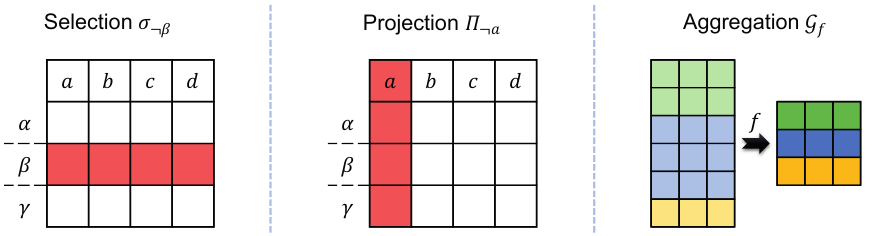
Figure 8. Graphical Illustration of the Effect of a Selection, Projection, and Aggregation on a